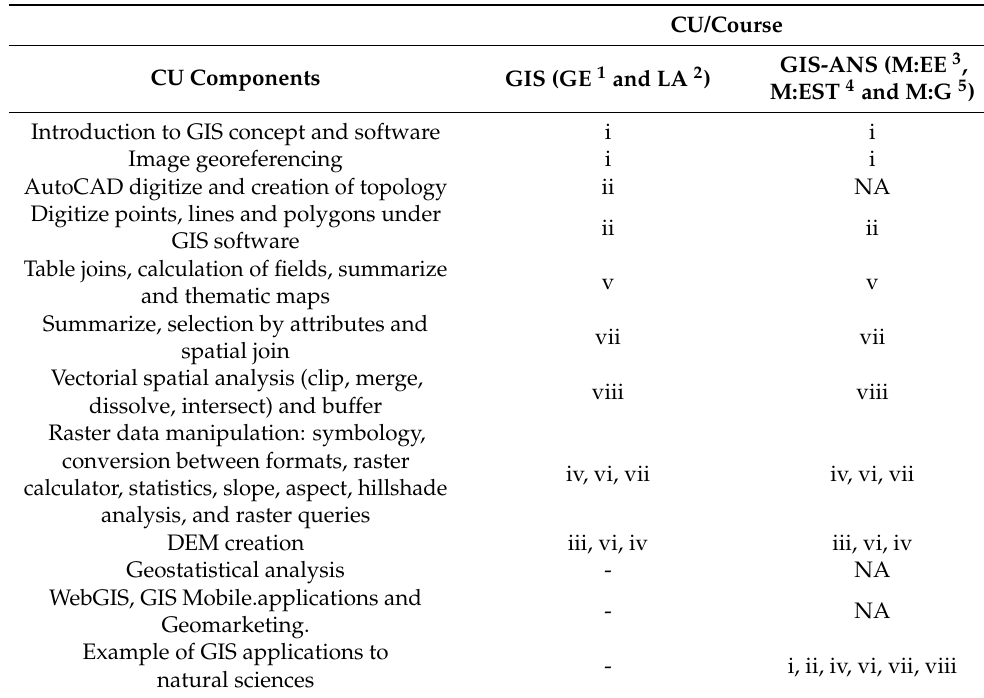
Table 3. Curricular units (CUs) components compared to STAT components. GIS: Geographic Information Systems; GIS-ANS: GIS Applied to Natural Sciences.